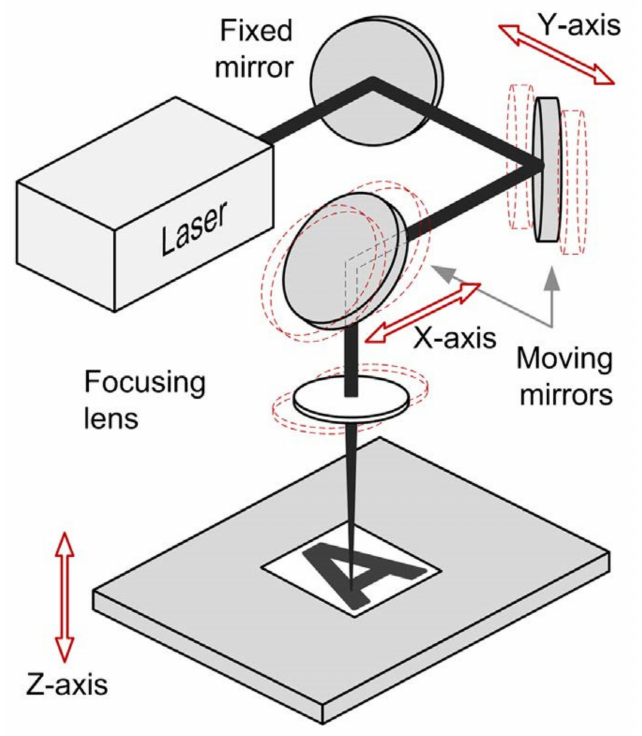
Figure 3. Direct-write CO 2 laser micromachine system